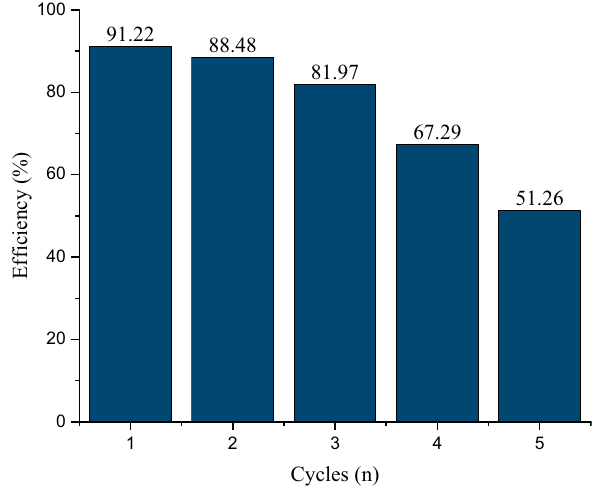
Figure 8. Reusability of the Bivalve Shell for Fluoride